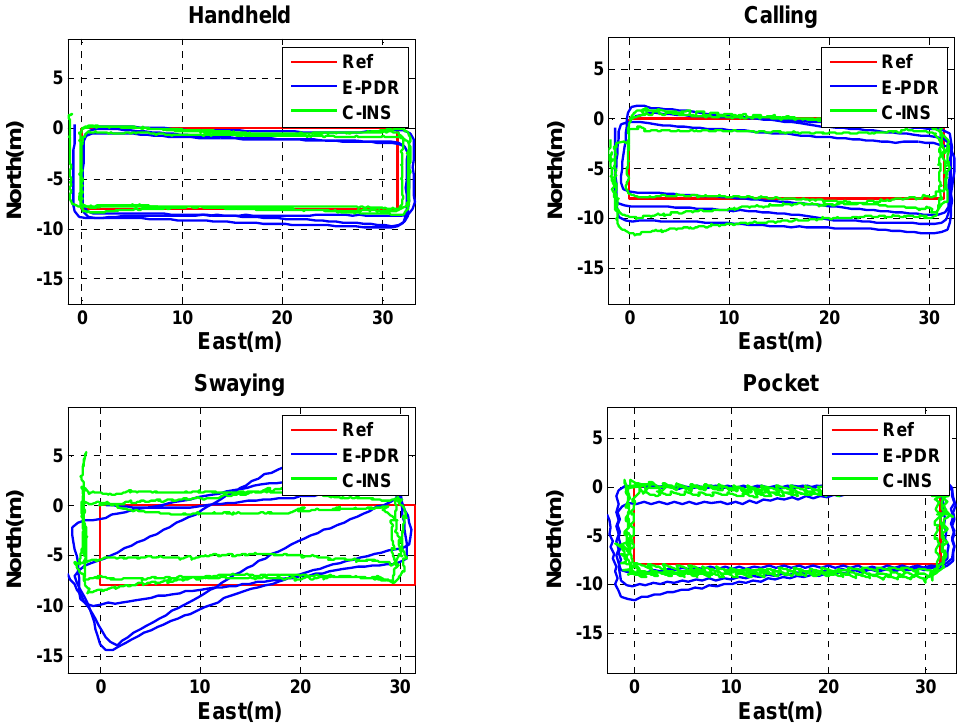
Table 1. Heading angle error of E ‐ PDR and C ‐ INS solution for four different phone ‐ holding positions (units of degree).